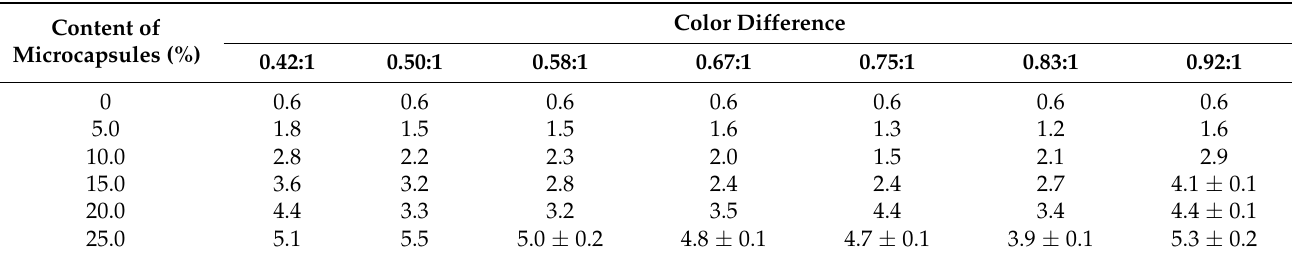
Table 1. Variation of color difference of water-based topcoat paint